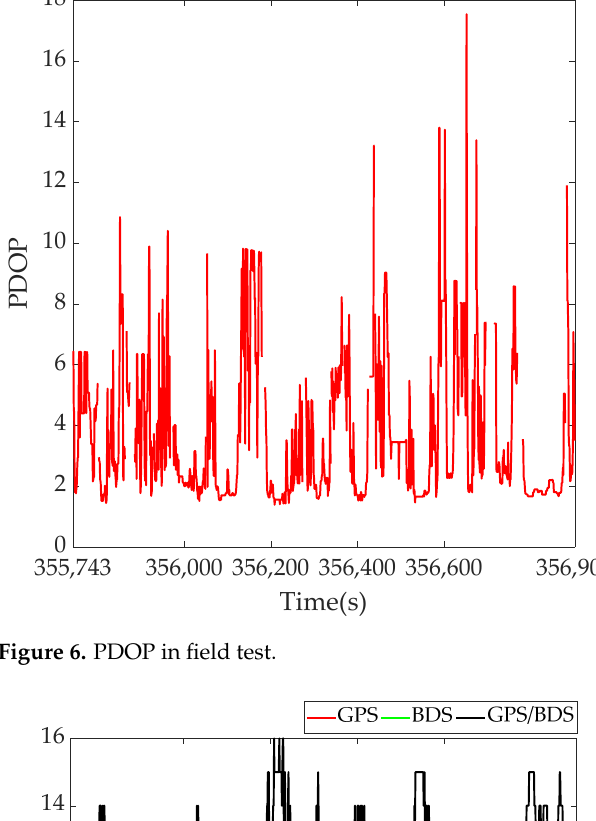
Figure 5. Vehicle trajectory in field test.